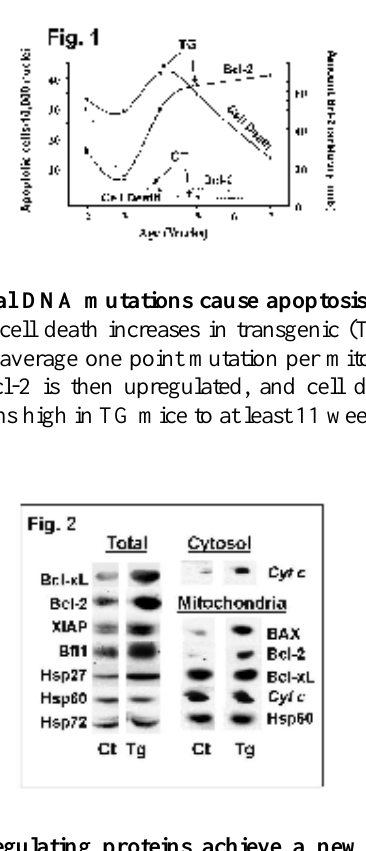
Fig. 2: Apoptosis-regulating proteins achieve a new balance in mice with mtDNA mutations. Proteins known to protect against apoptosis (Bcl-xL, Bcl-2, XIAP, Bfl-1, and HSP27) are upregulated at the whole heart (total) level. HSPs 60 and 72 show no change, demonstrating that changes reflect a specific response. Despite this heightened protection, we see increased release of cytochrome c (cytosol) and increased proapoptotic BAX on mitochondria. Much of the Bcl-2 increase is due to mitochondrially localized protein, while the Bcl-xL response is not targeted to mitochondria. Specificity controls in the mitochondrial fraction are cyt c and HSP